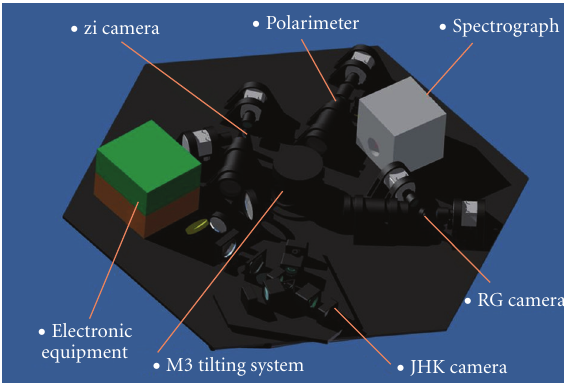
Figure 6: The mounting scheme of the Instrumentation at the Cassegrain Focal Plane of